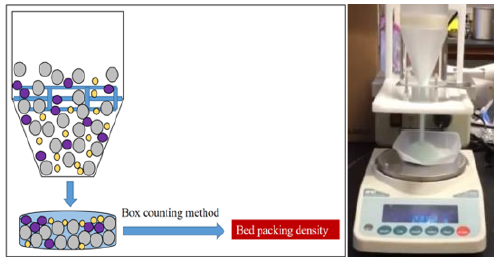
Fig. 4. a) Schematic of the hopper discharge to calculate the bed packing density for the deposited powder, b) Experimental setup for hopper discharge for bond number